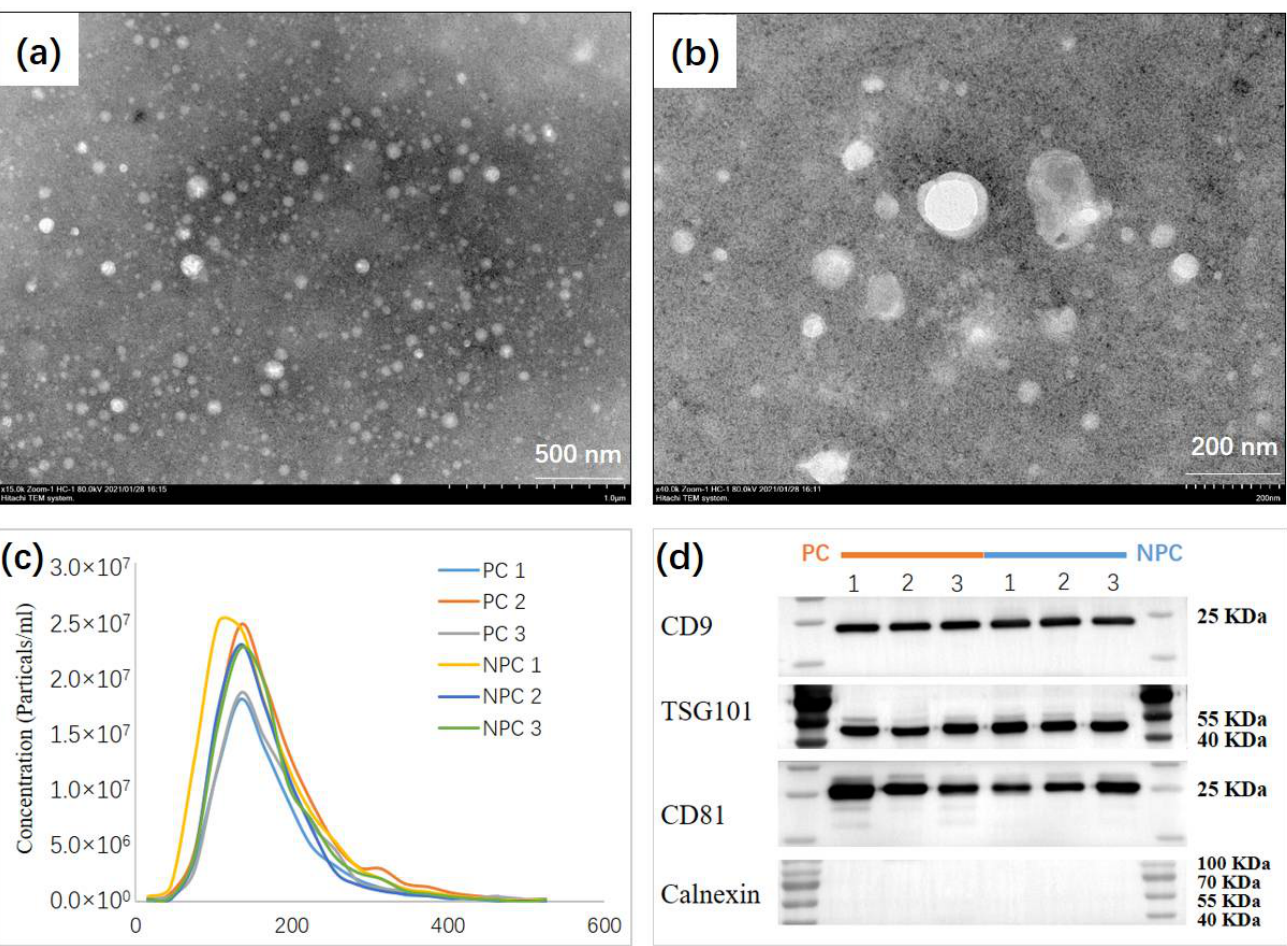
Figure 2. Biochemical and Morphological Characterization of EVs. ( a , b ), TEM image of urine EV from selected individuals showing the typical exosome-round size (~150 nm) and morphology. ( c ) NTA of urine EV revealing a similar EV mode (~150 nm) between prostate cancer cases (n = 3), and non-prostate cancer controls (n = 3). ( d ) Representative immunoblots indicating that the EV isolated from the urine of selected individuals present enrichment of the EV markers CD9, TSG101, and CD81 but do not contain Calnexin used as control.